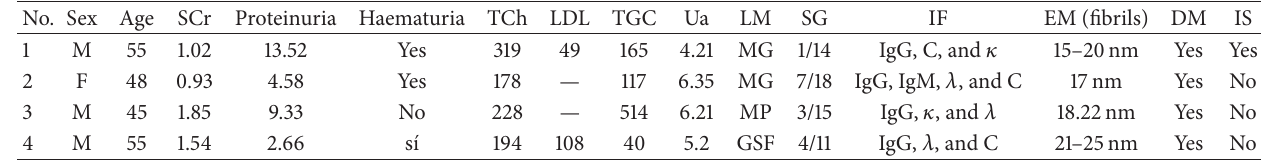
Table 1: Clinical, biochemical, and histologic data from patients with fibrillary glomerulonephritis.